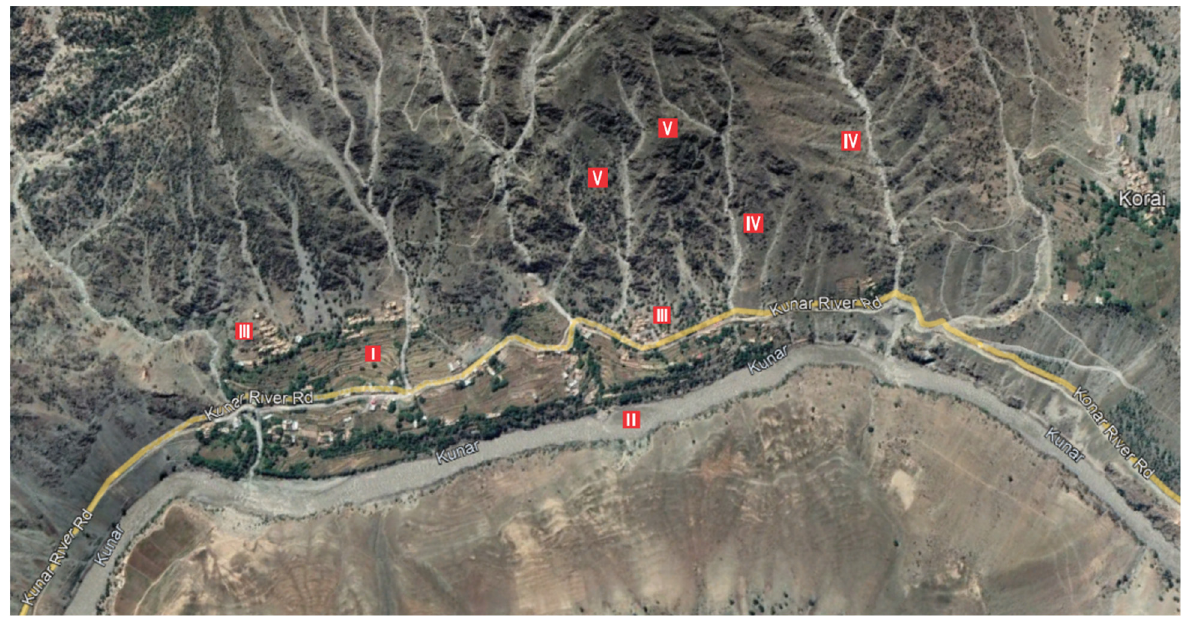
Figure 4. M. buxifolia forest sampling location at Pak-Afghan border envisage (Hindukush range) I. agriculture land, II. Kunar River, III. local community, IV. meander streams, V. Monotheca forests.